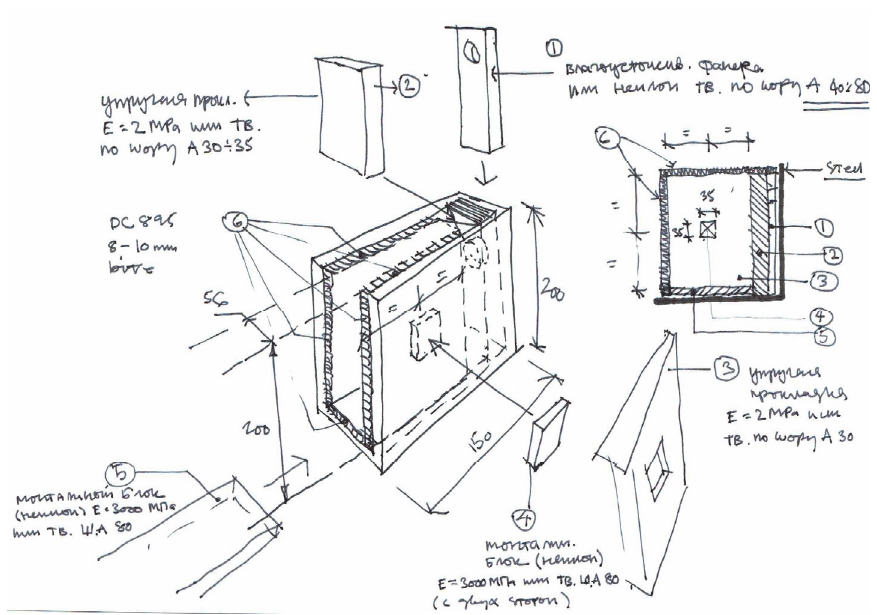
Fig. 8: Detailing of the Silicone Connections